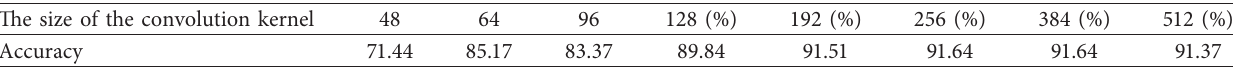
Table 2: Influence of the size of convolution kernels in the wide convolution layer on the 1D-WDRSN